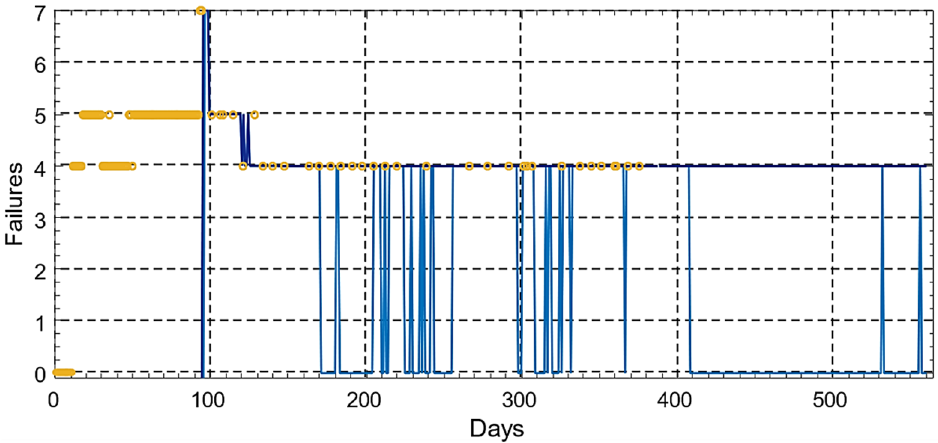
Figure 56. Evolution of failures according to Duval’s method for offline (yellow), online without (dark blue), and with (blue) change rate conditions.